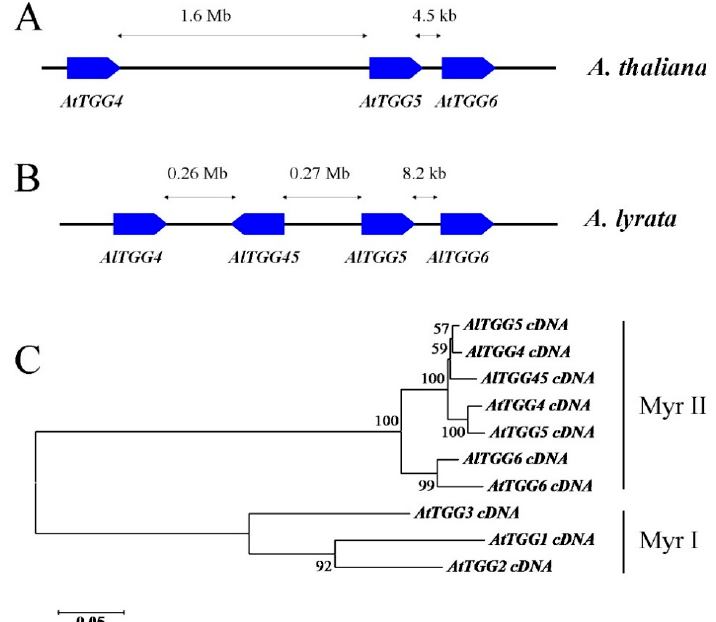
Figure 1. Chromosomal locations and phylogenetic analysis of Myr II members in Arabidopsis lyrata and A. thaliana . ( A ) Chromosomal locations of Myr II genes in A. thaliana ; ( B ) Chromosomal locations of Myr II genes in A. lyrata ; ( C ) Phylogeny inferred from cDNAs of Myr II members in A. thaliana and A. lyrata , using Myr I myrosinases AtTGG1 (At5g26000), AtTGG2 (At5g25980), and AtTGG3 (At5g48375) as outgroups. Note: AtTGG4 (At1g47600) and AtTGG5 (At1g51470) cDNA sequences were from ecotype Col-0, AtTGG6 (At1g51490) sequence was from ecotype Tsu-1 (GenBank accession number KU301834). AlTGG cDNA sequences were obtained by annotating a genomic scaffold (NW_003302555) in A. lyrata , and partially confirmed by sequencing the PCR-amplified cDNAs. The sequences were deposited in the GenBank database under accession numbers KU301856, KU301857, KU301858, and KU301859 for AlTGG4 , AlTGG5 , AlTGG6 , and AlTGG45 , respectively.